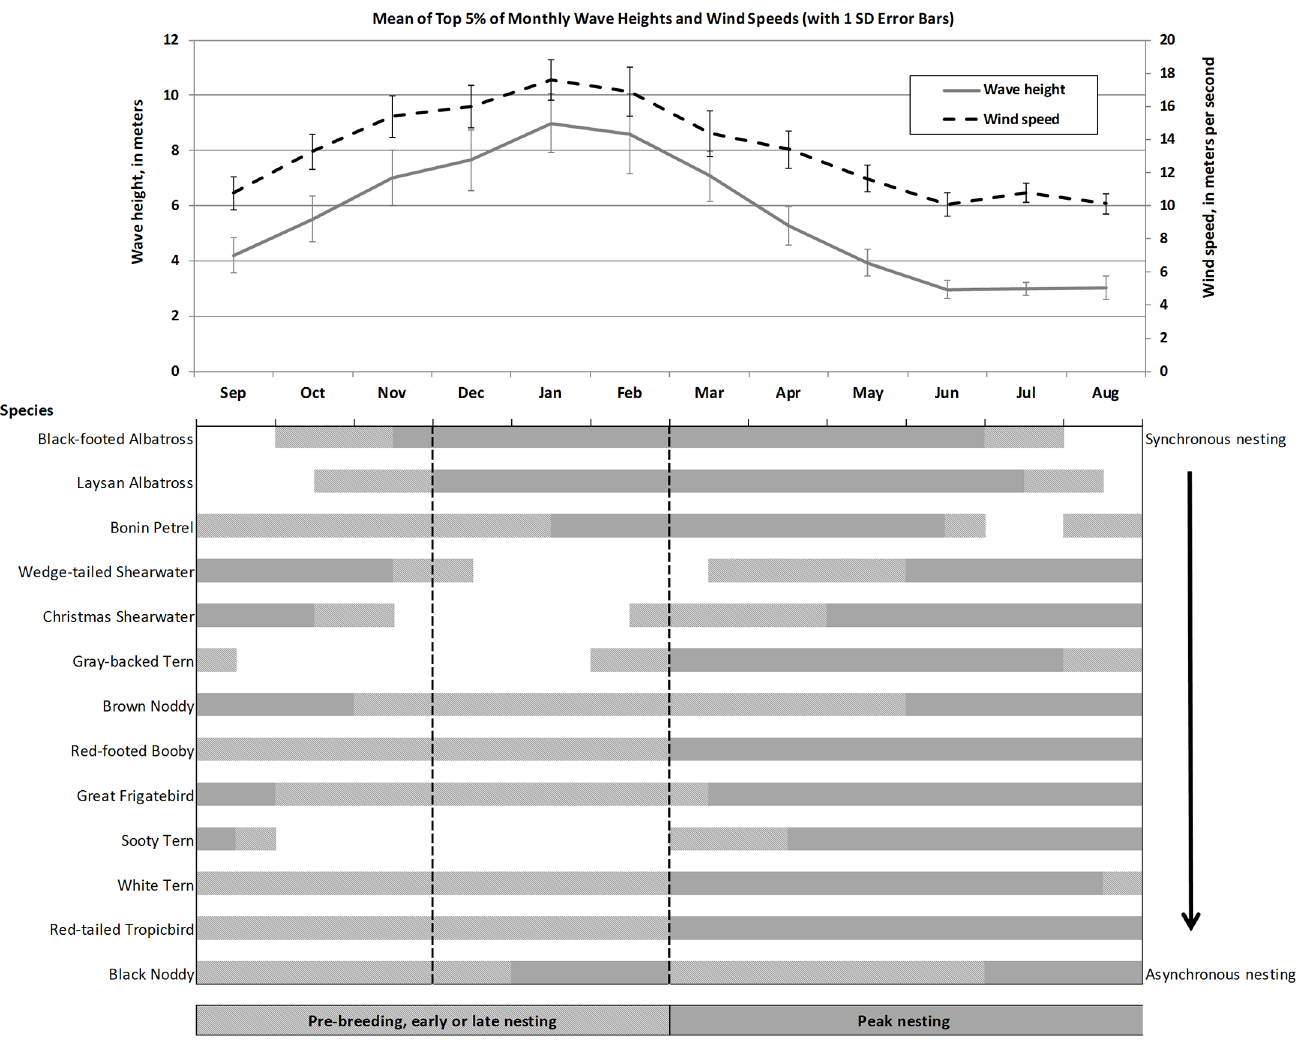
Fig 2. Breeding phenology and synchrony of select ( > 100 pairs) seabird species at Midway Atoll compared with the monthly mean of the top 5% of wave heights and wind speeds. Monthly mean of top wave heights and wind speeds ( ± 1 standard deviation; [27]) were derived from hindcast data for the years 1981 – 2004 at 28° 00 ’ N, 174° 00 ’ W (375 km east of Sand Island). Peak nesting period includes incubation and chick rearing. Species listed in descending order of nesting colony synchrony (observed at Midway